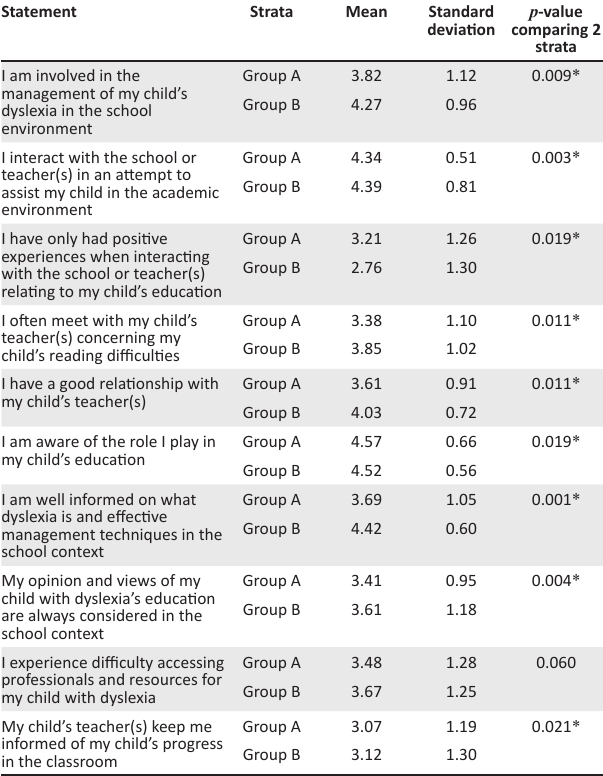
TABLE 3: Mean, standard deviation and p-value comparing parental involvement in Group A and Group B. Statement